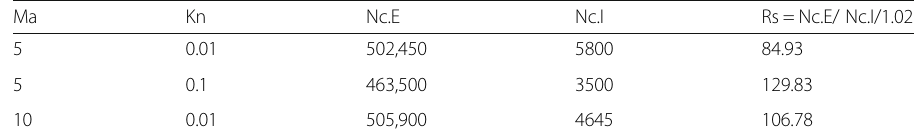
Table 2 Comparison of the explicit and implicit methods in convergence rate Ma Kn Nc.E Nc.I